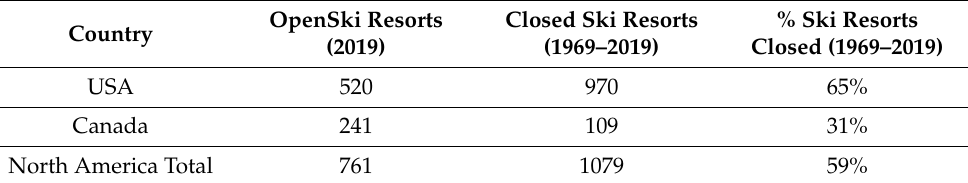
Table 1. Summary of findings North American Ski Resorts (changes from 1969 to 2019).